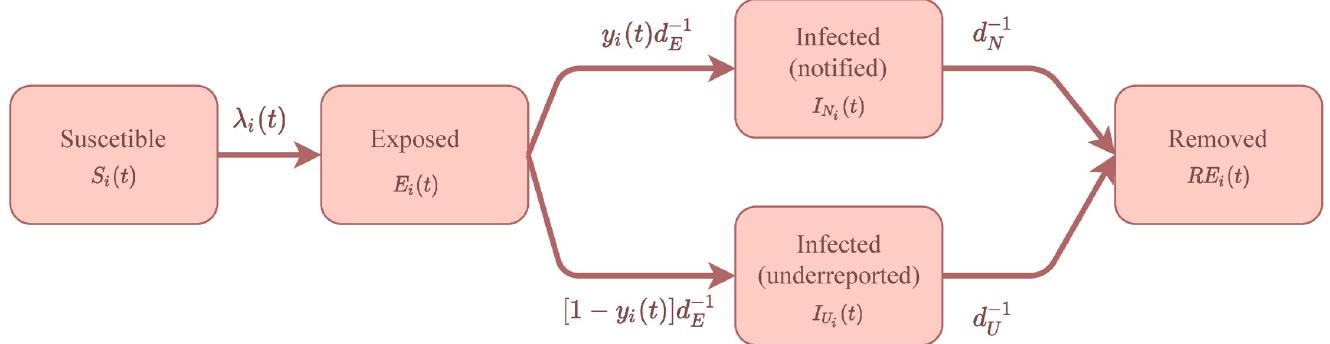
Fig 2. SENUR model. Schematic for the SENUR model used in this work.